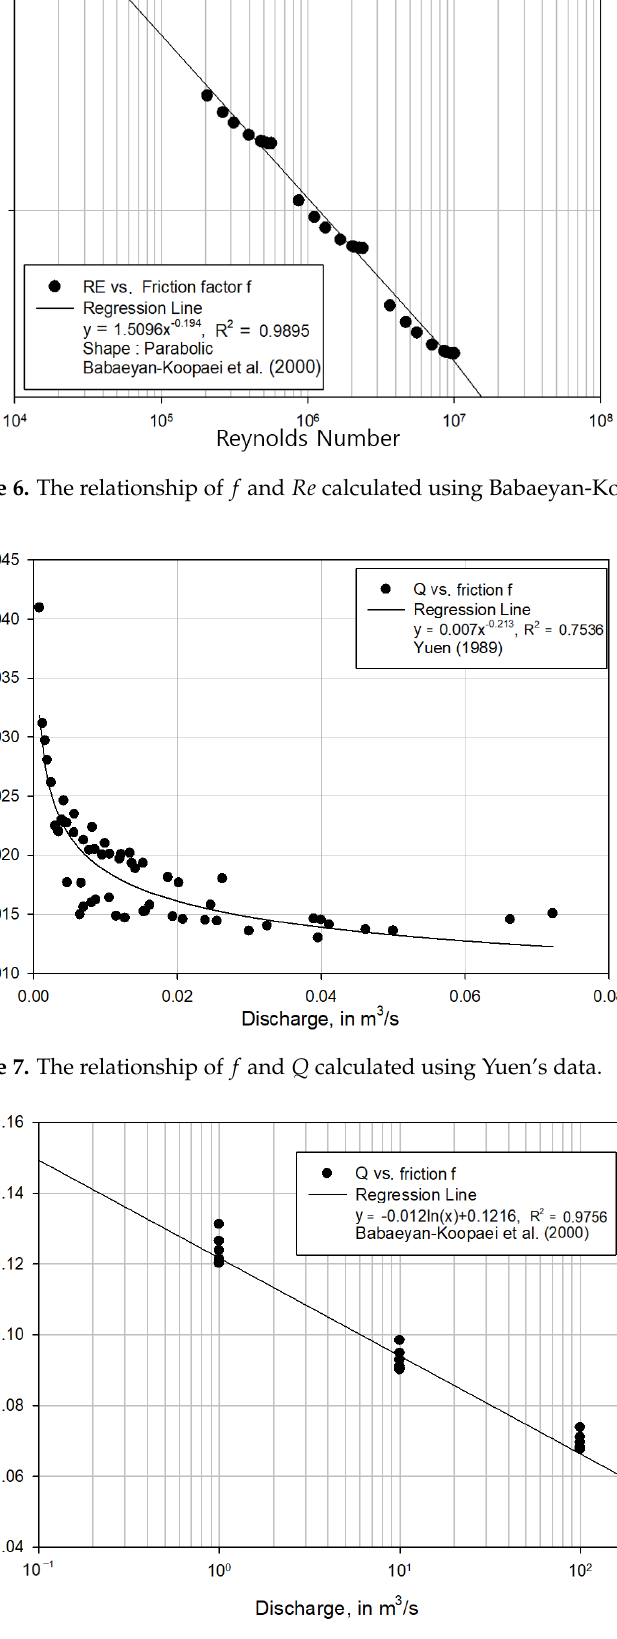
Figure 8. The relationship of (cid:1858) and (cid:1843) calculated using Babaeyan-Koopaei’s data.